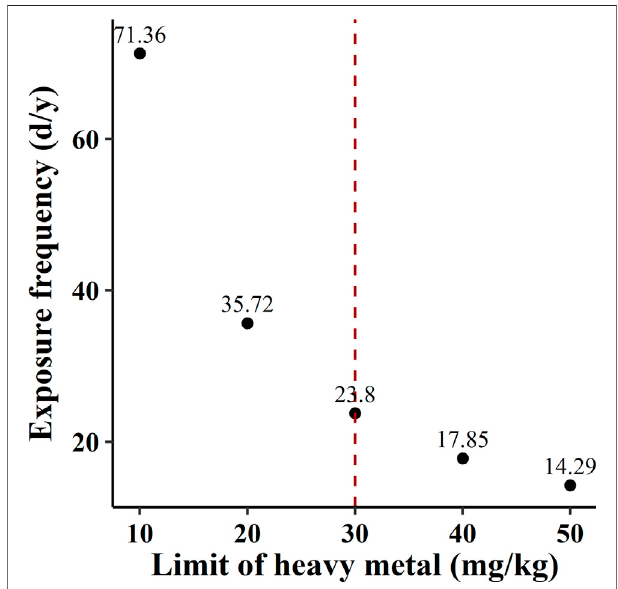
FIGURE 5 | Exposure frequency for safety under different metal limit standards. The dashed line represents the limits set in the Chinese Pharmacopoeia 2020